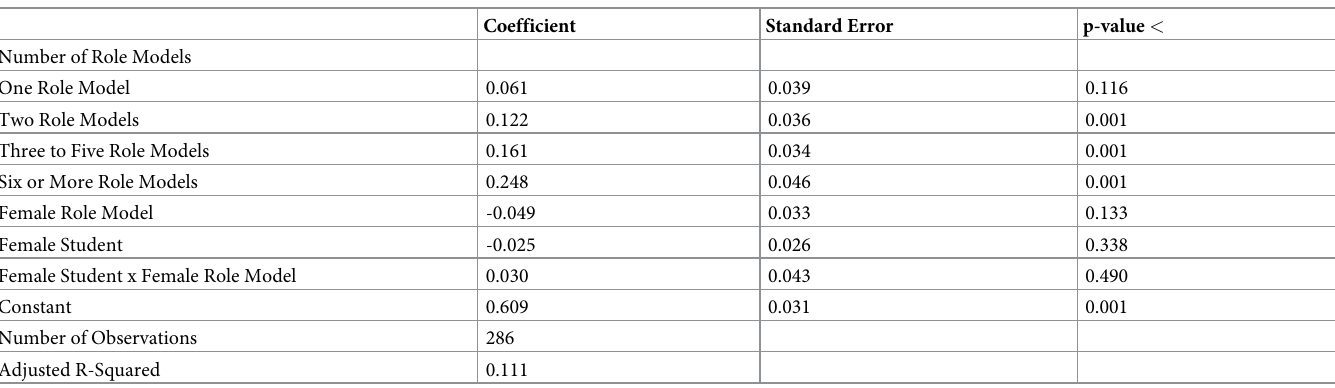
Table 3. Correlates of general academic self-efficacy